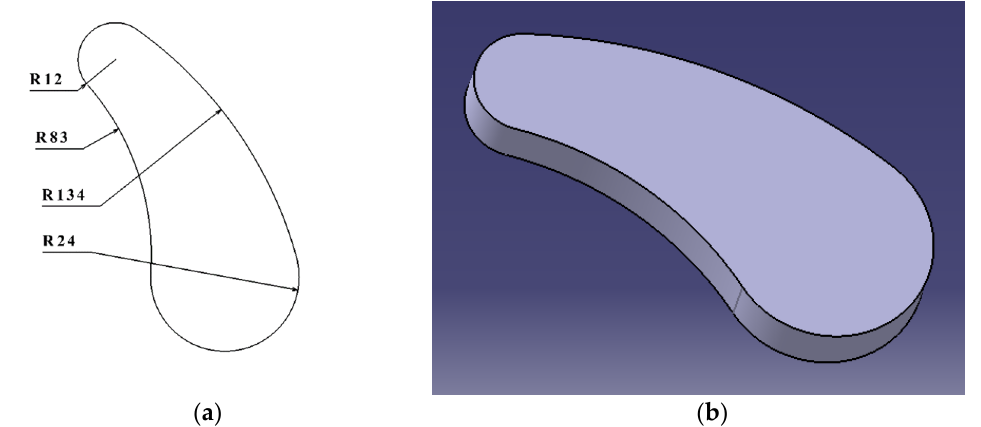
Figure 3. Bionic-pattern model: ( a ) schematic diagram of the bionic unit, the unit is mm; ( b ) structural diagram of the bionic unit.